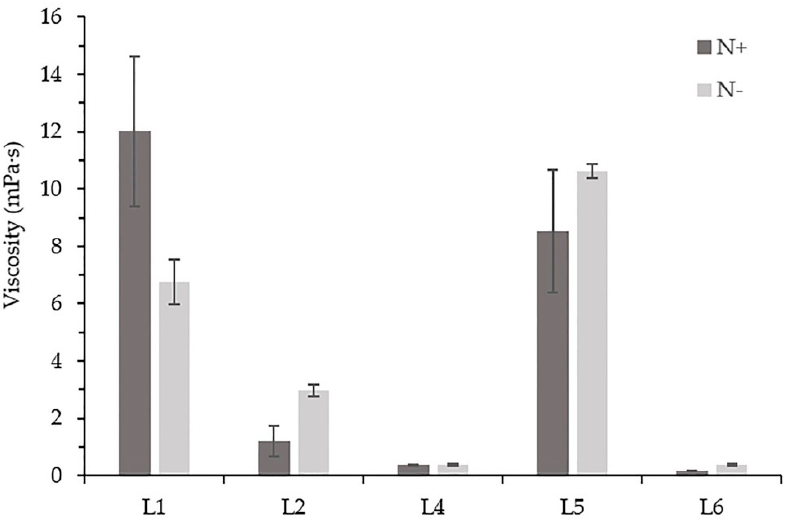
Figure 2. The viscosity of cell-free media of isolated strains in the 7th week of cultivation. The error bars indicate standard deviation.